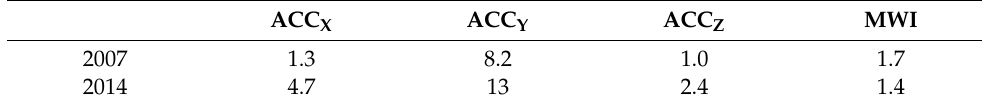
Table 1. Analytical ACC noise ASD parameters a for a model a / 10 − 10 m/s 2 , and the MWI noise parameters b for a constant model (frequencies above 10 mHz) in 10 − 6 m.